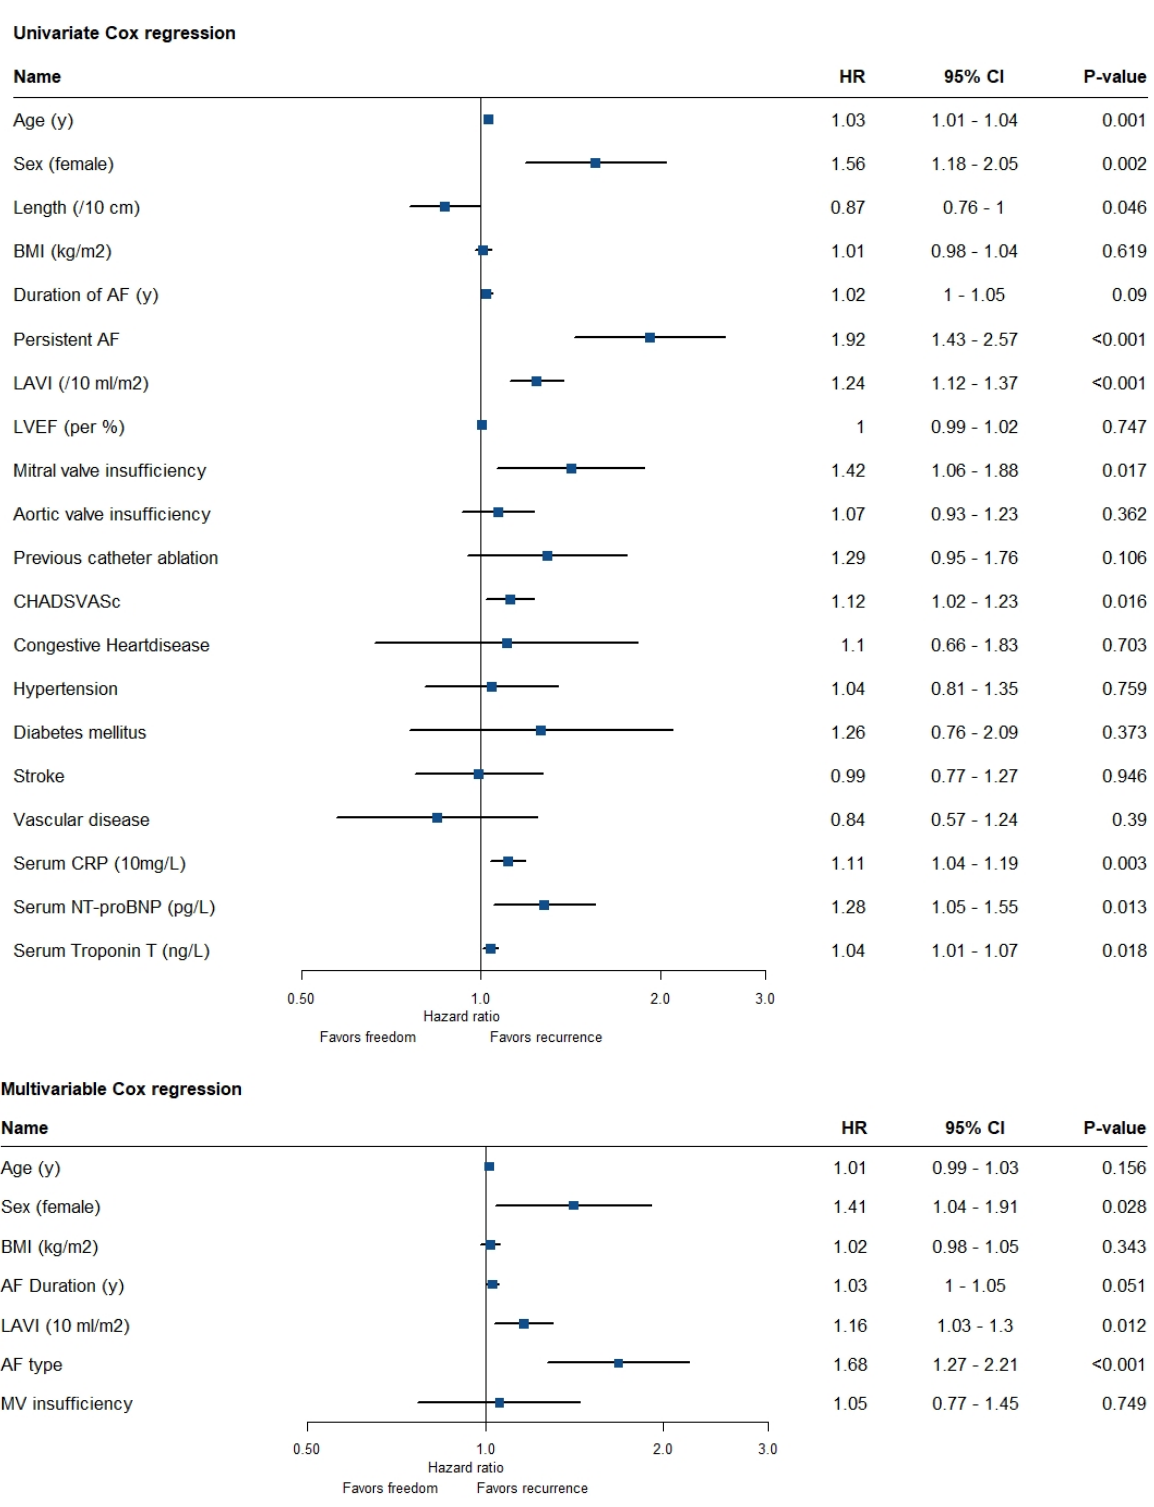
Figure 2. Univariate and multivariable Cox regression of patient characteristics and freedom of AF recurrence, for all included patients. AF atrial fibrillation, BMI body mass index, CI confidence interval, cm centimeter, CRP c-reactive protein, HR hazard ratio, kg kilogram, LAVI left atrial volume index, LVEF left ventricular ejection fraction, m meter, mL milliliter, MV mitral valve, ng nanogram, NT-proBNP n-terminal pro-brain natriuretic peptide, pg pictogram, y years µg microgram.